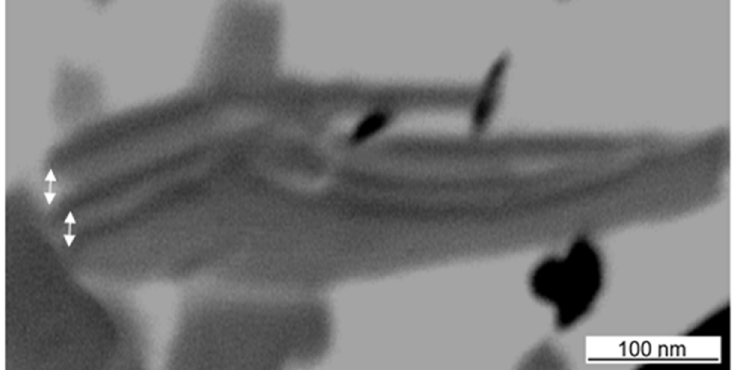
Figure 4. TEM analysis of an intercalated kaolinite platelet with Kln/a-SMA = 70:30, showing the kaolinite layers and increment in interlayer distance